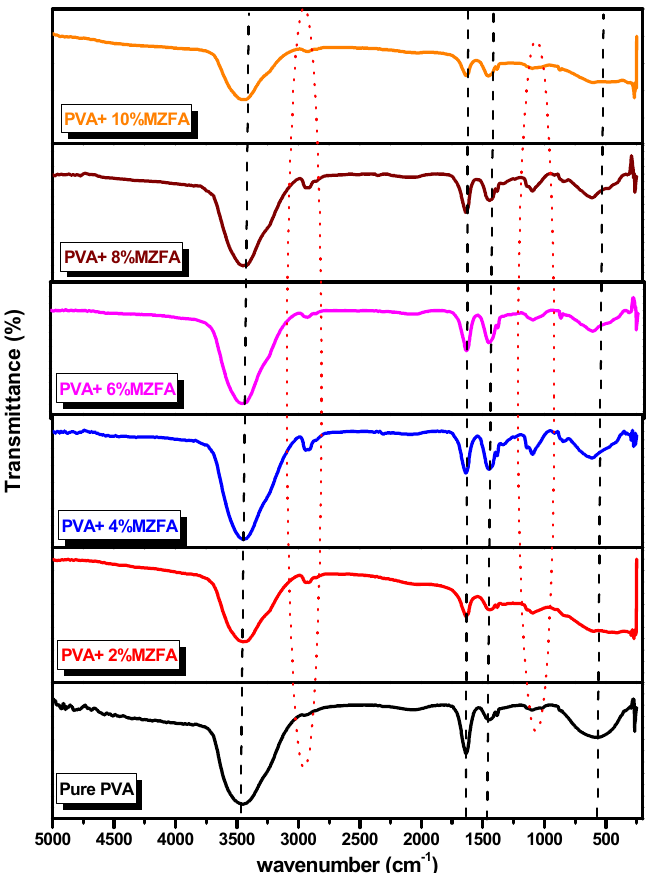
Figure 4. FTIR spectrums of the pure PVA polymer and synthesized PVA/MZFA composite films.